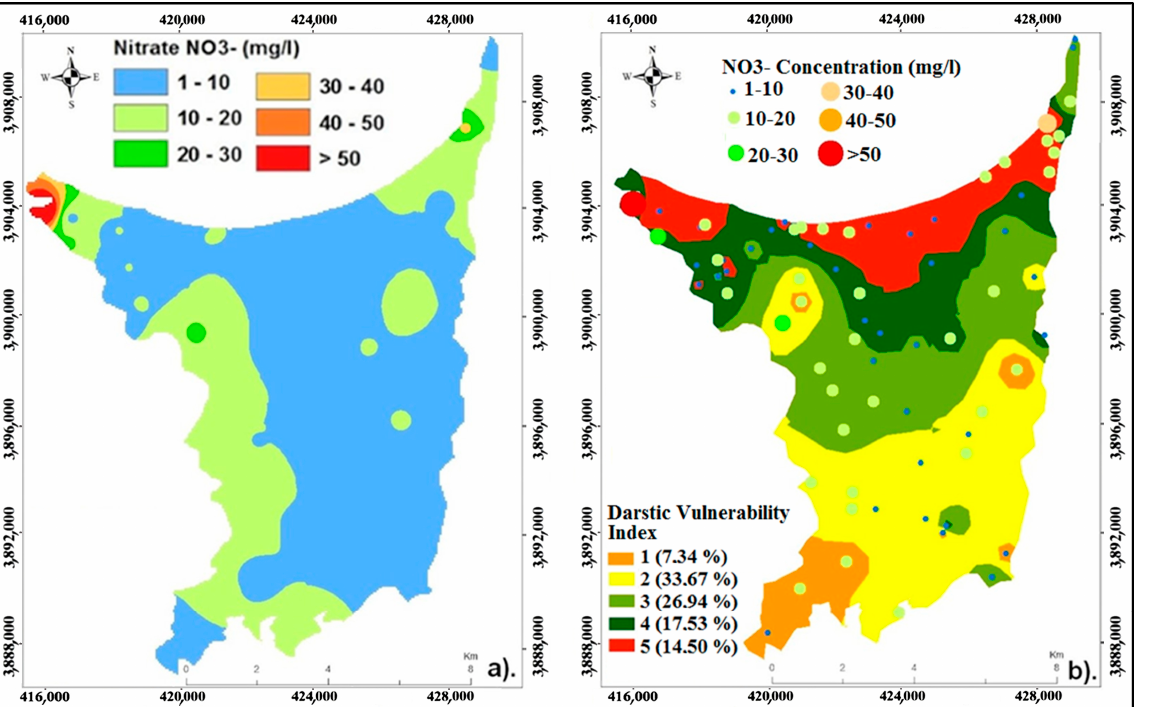
Figure 6. ( a ) Nitrate concentration distributions in the groundwater of Ghiss Nekkor, ( b ) vulnerability map and concentrations of nitrates for the study zone.